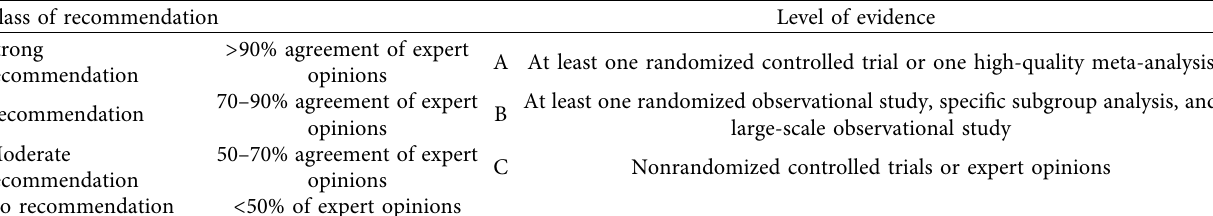
Table 1: Definitions for the class of recommendation and level of evidence in this